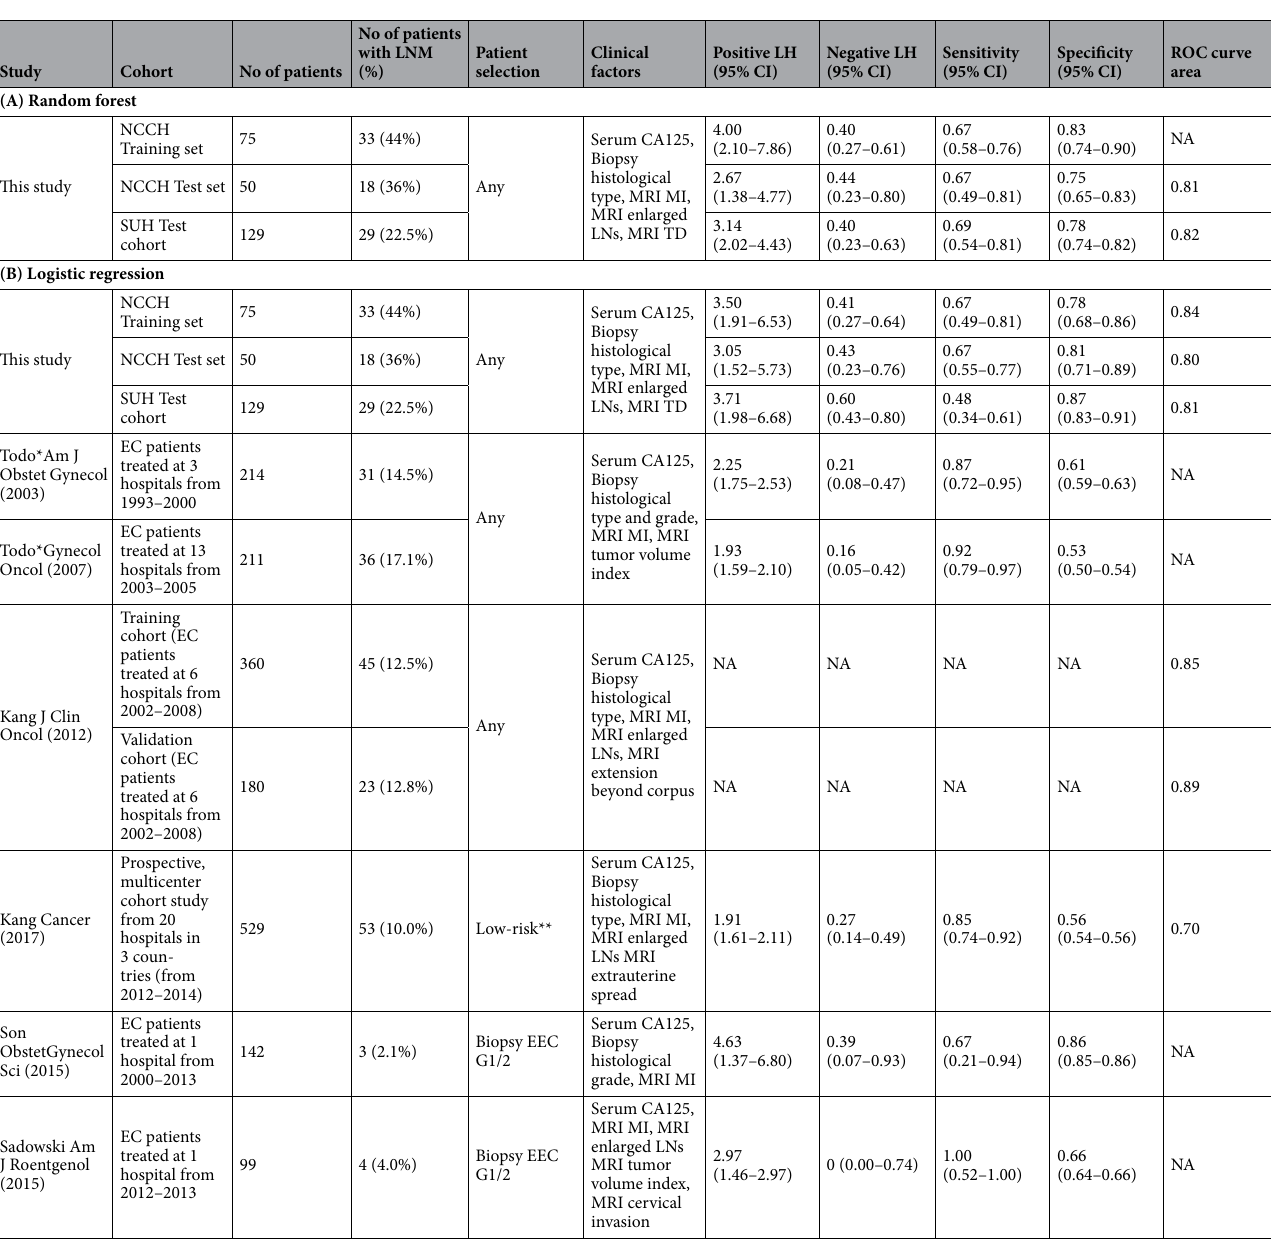
Table 3. Comparison of the preoperative prediction models for lymph node metastasis in patients with endometrial cancer. LNM Lymph node metastasis, LH Likelihood ratio, CI Confidence interval, ROC